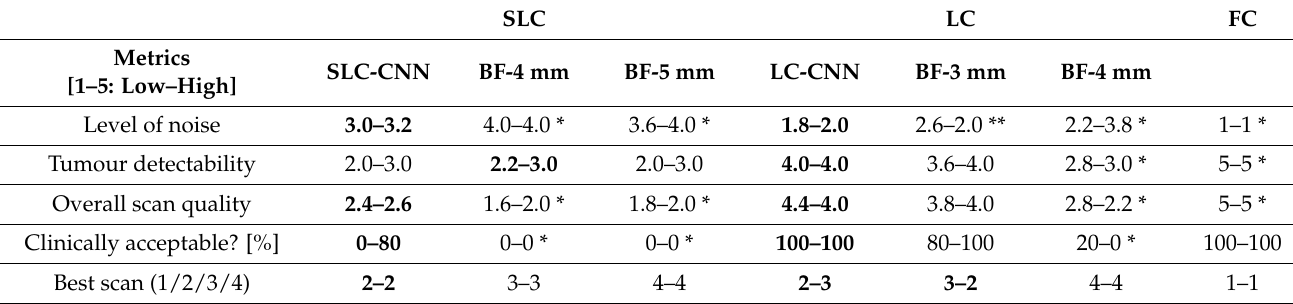
Table 3. Scores provided by the Nuclear Medicine Physicians as part of qualitative assessment of the denoised 18 F-FDG PET scans. The best performing method is indicated in bold based on the average score of both physicians.